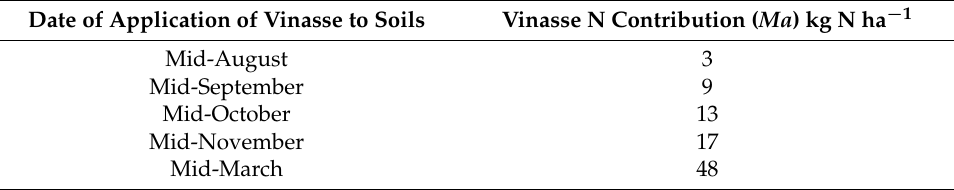
Table 1. Calculation of the net N contribution ( Ma ) from vinasse between the opening and closing dates of the N balance for sugar beet crops using AzoFert ® according to the date of application. Date of Application of Vinasse to